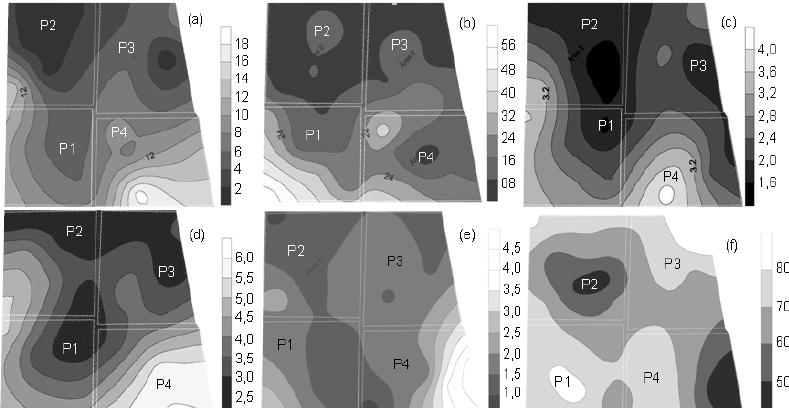
(%).Figura 4. Mapas de contorno de atributos químicos do solo selecionados na profundidade de 0 a 20 cm, das parcelas experimentais da PIF coco, Frutese, Platô de Neópolis, SE, em que P1, P2, P3 e P4 são, respectivamente, parcelas 1, 2, 3 e 4: (a) CO (g kg -1 ); (b) P (mg kg -1 ); (c) Ca + Mg (cmol (cmol kg -1 ); (e) relação Ca/Mg; e (f) V (%). c